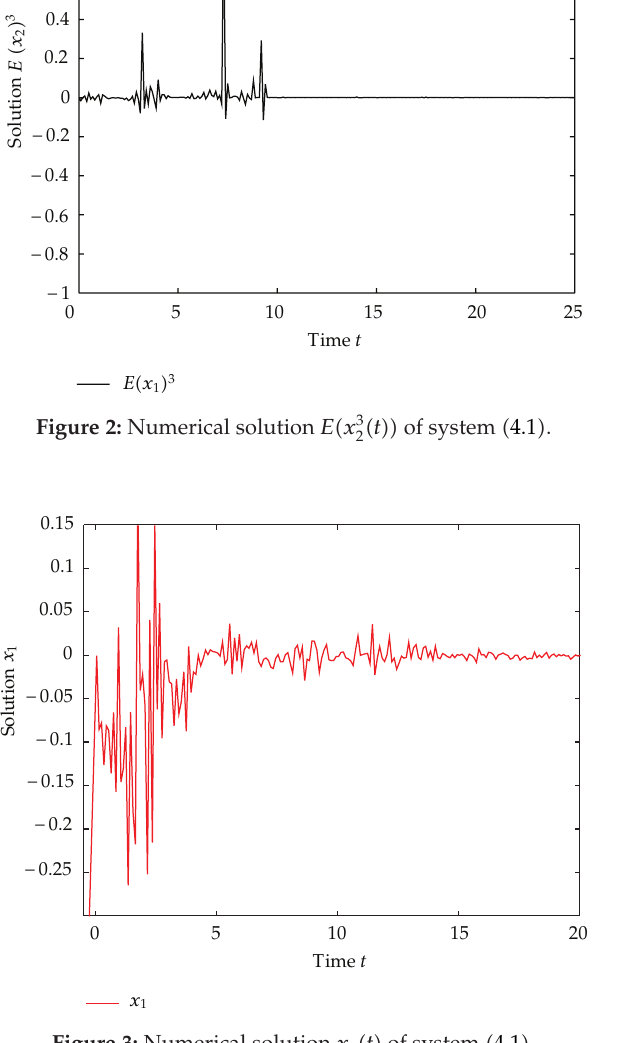
Figure 3: Numerical solution x 1 (cid:6) t (cid:7) of system (cid:6) 4.1 (cid:7)